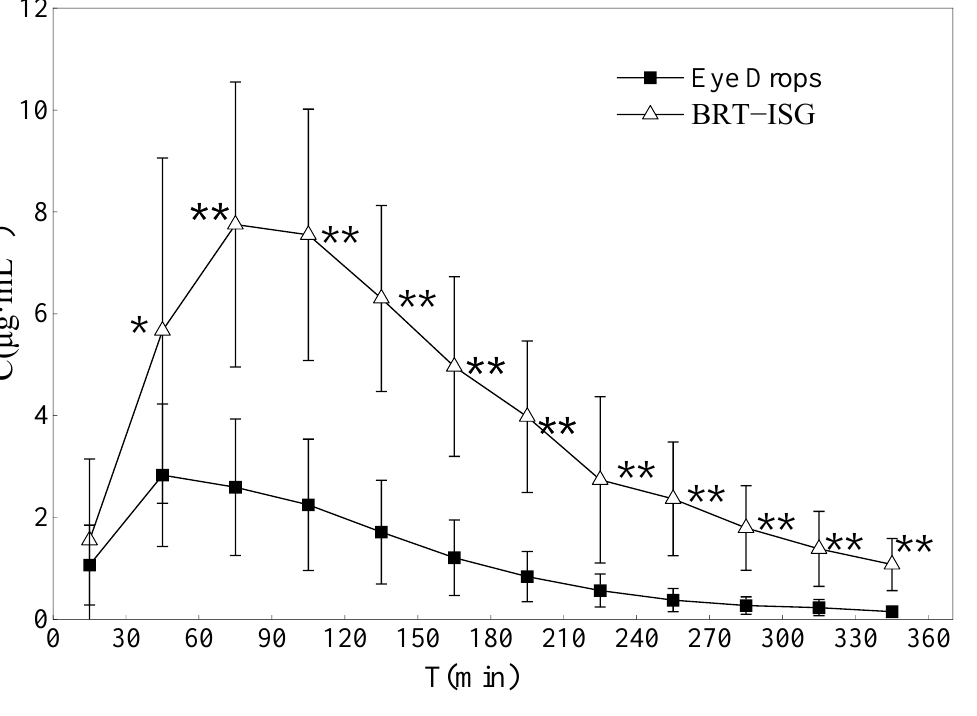
Figure 8. Concentration of Brimonidine in the aqueous humor of rabbits after administration of eye drops and BRT − ISG ( n = 10, x ± s). * p < 0.05 and ** p < 0.01 BRT − ISG vs. eye drops. Table 5. The main pharmacokinetic parameters of Brimonidine in aqueous humor after topical administration ( n = 10, x ± s). Parameter Eye